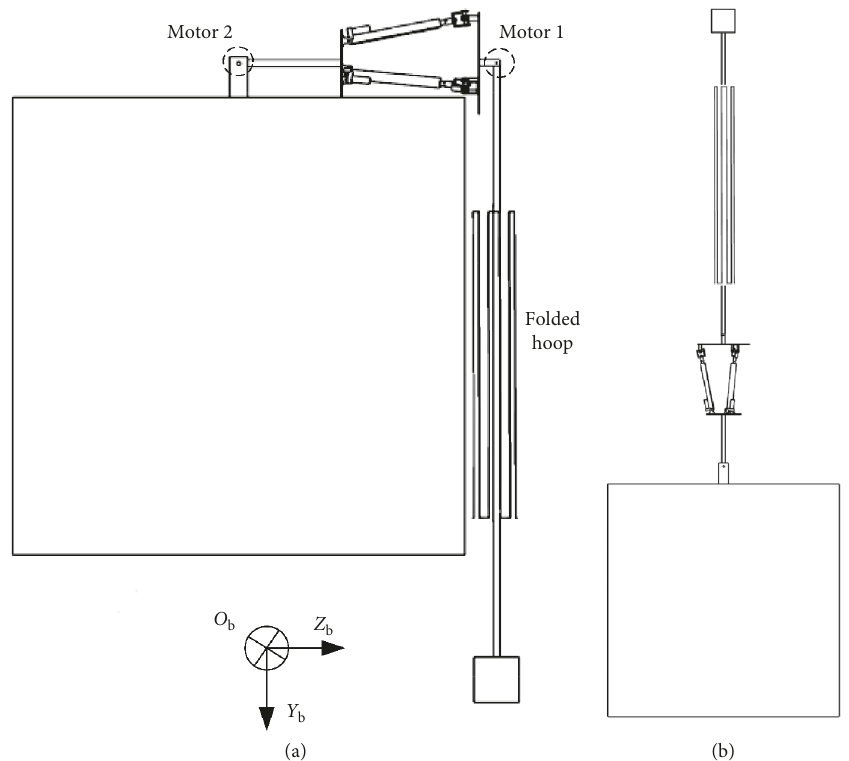
Figure 15: Simulation model of the support structure: (a) status 1; (b) status 2.